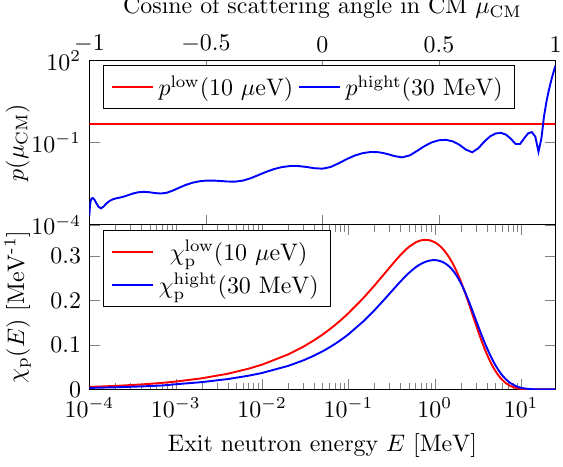
Figure 1. Two 239 Pu extreme elastic scattering angular distribu- tions and fission spectra used to test the perturbation calculation.